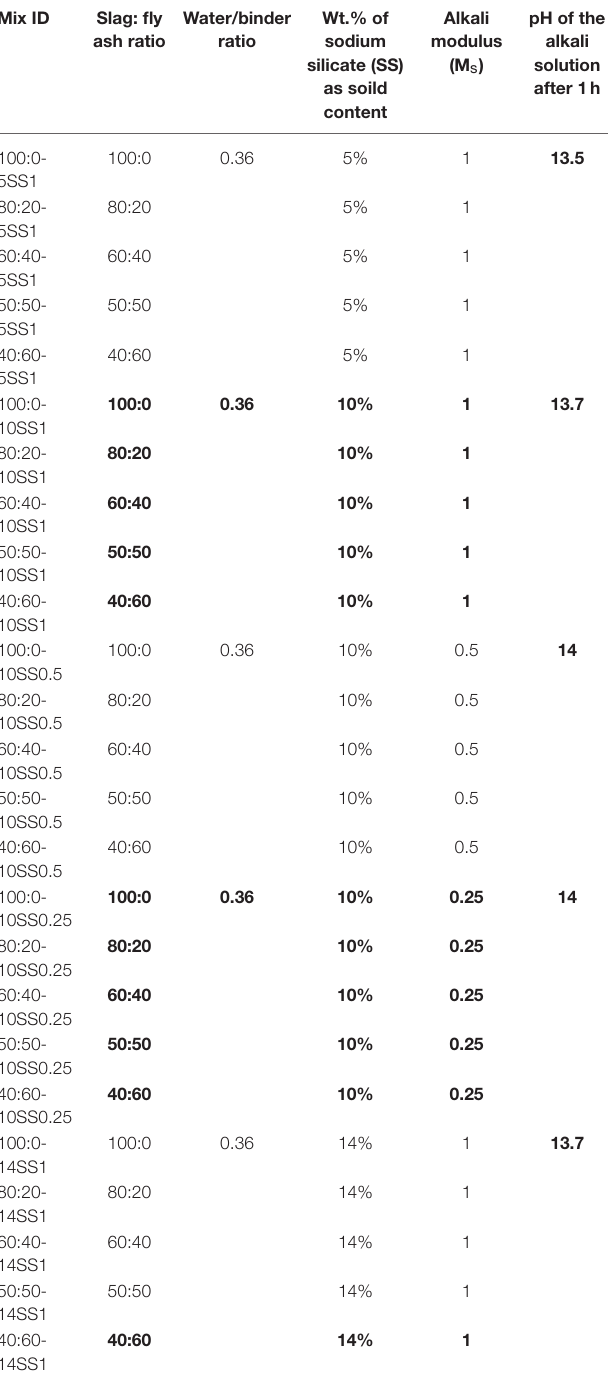
TABLE 2 | Mix proportions of pastes.